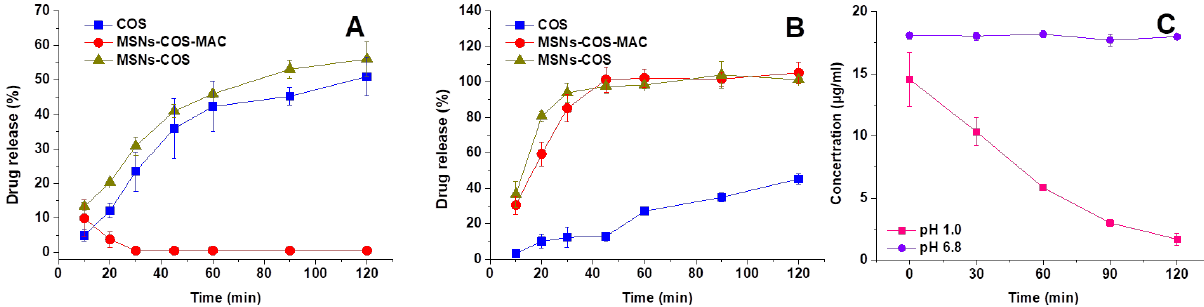
Figure 4. Release profiles of COS from pure COS, MSNs-COS and MSNs-COS-MAC in pH 1.0 hydrochloric acid containing a 0.5% SDS dissolution medium ( A ) and a phosphate buffer of pH 6.8 containing 0.5% SDS ( B ). ( C ) The molecular stability of COS in pH 1.0 hydrochloric acid containing a 0.5% SDS dissolution medium and a phosphate buffer of pH 6.8 containing 0.5% SDS. Each data point represents the mean ± SD of three